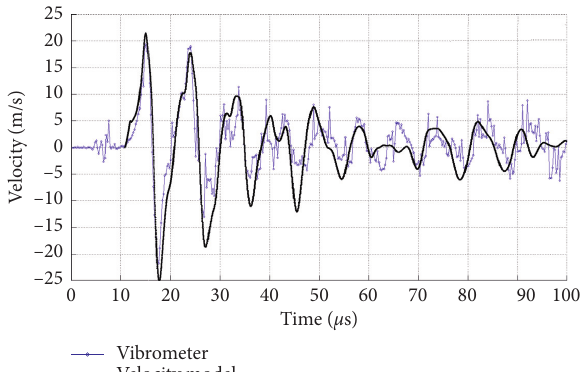
Figure 22: Results of the medium-intensity test on Glidcop ® , radial velocity without smoothing function. Acquired signal (blue) compared with simulated one (black).